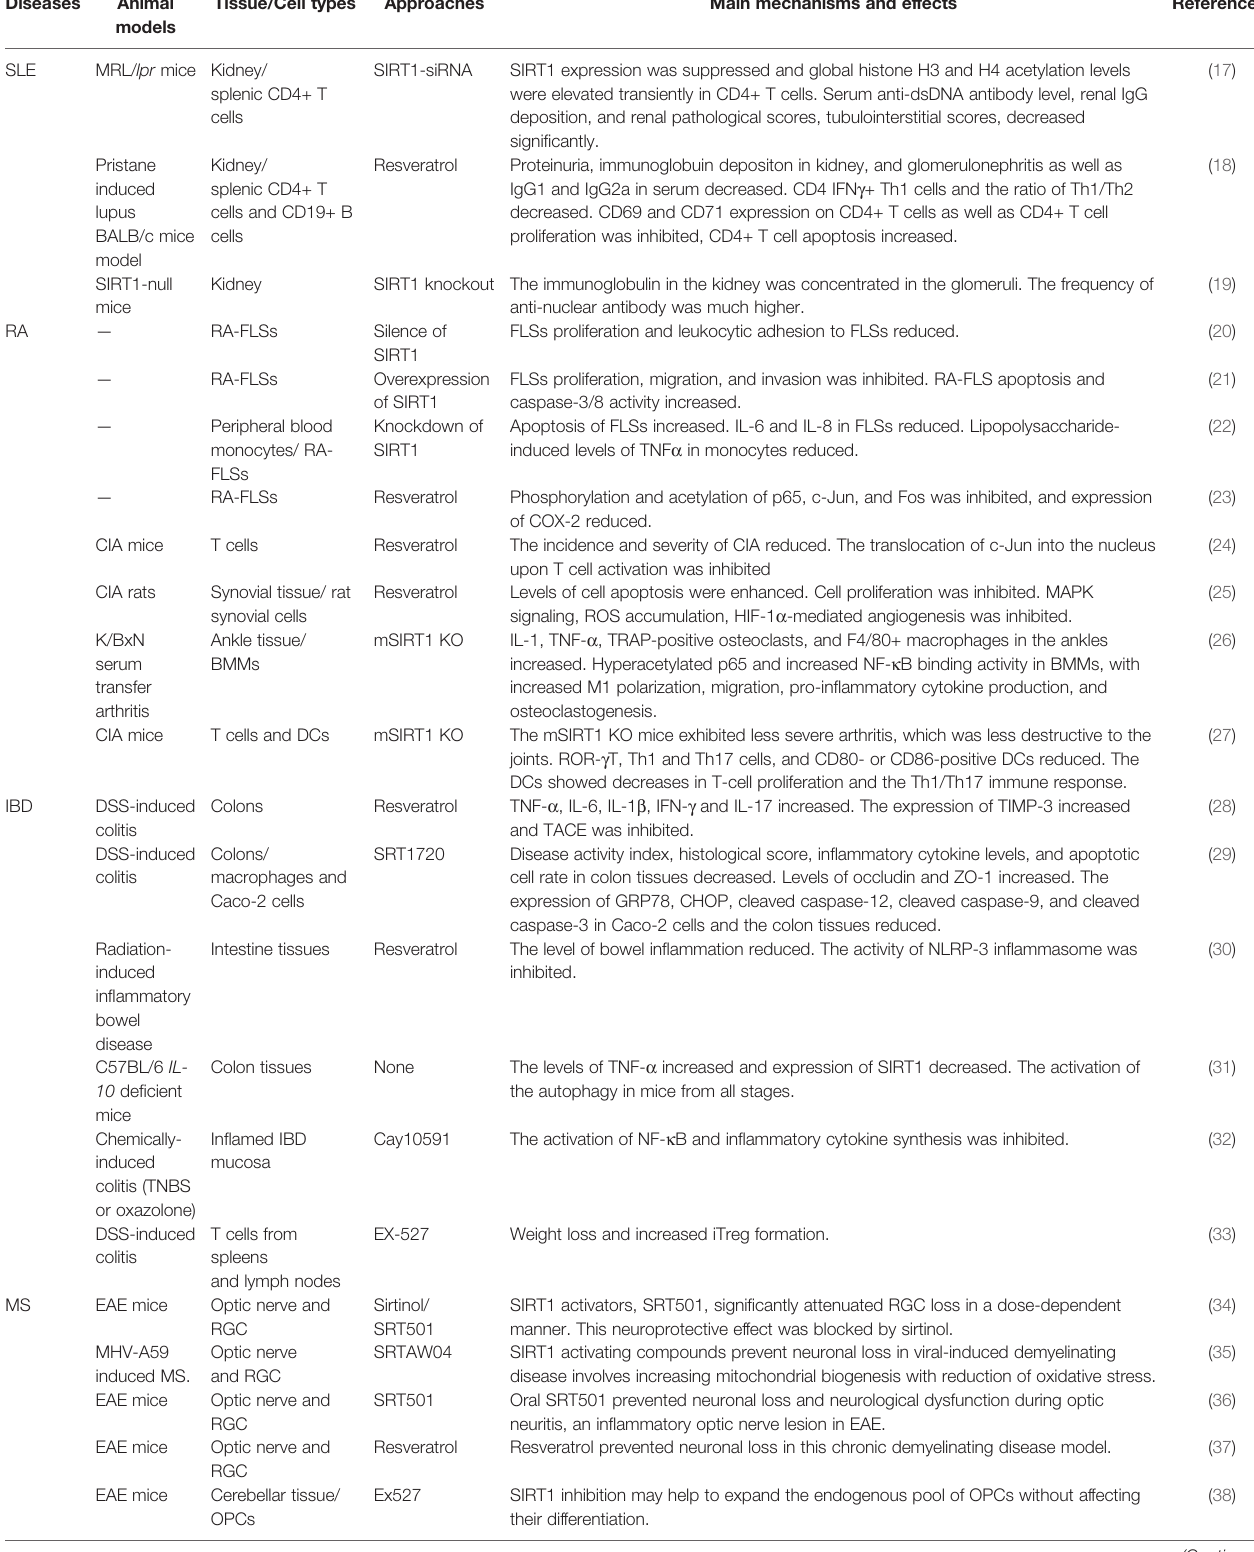
TABLE 1 | The role of SIRT1 modulation on autoimmune diseases. Diseases Animal